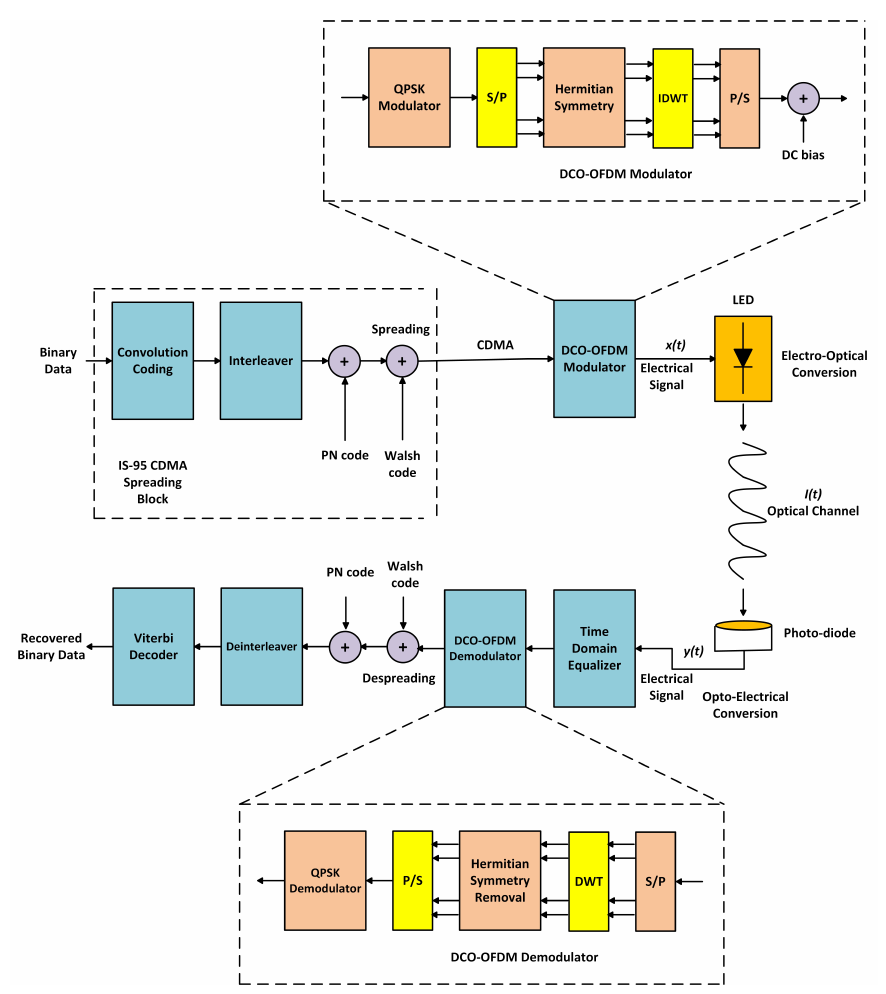
Figure 2. Modeling of wavelet-based MC-CDMA